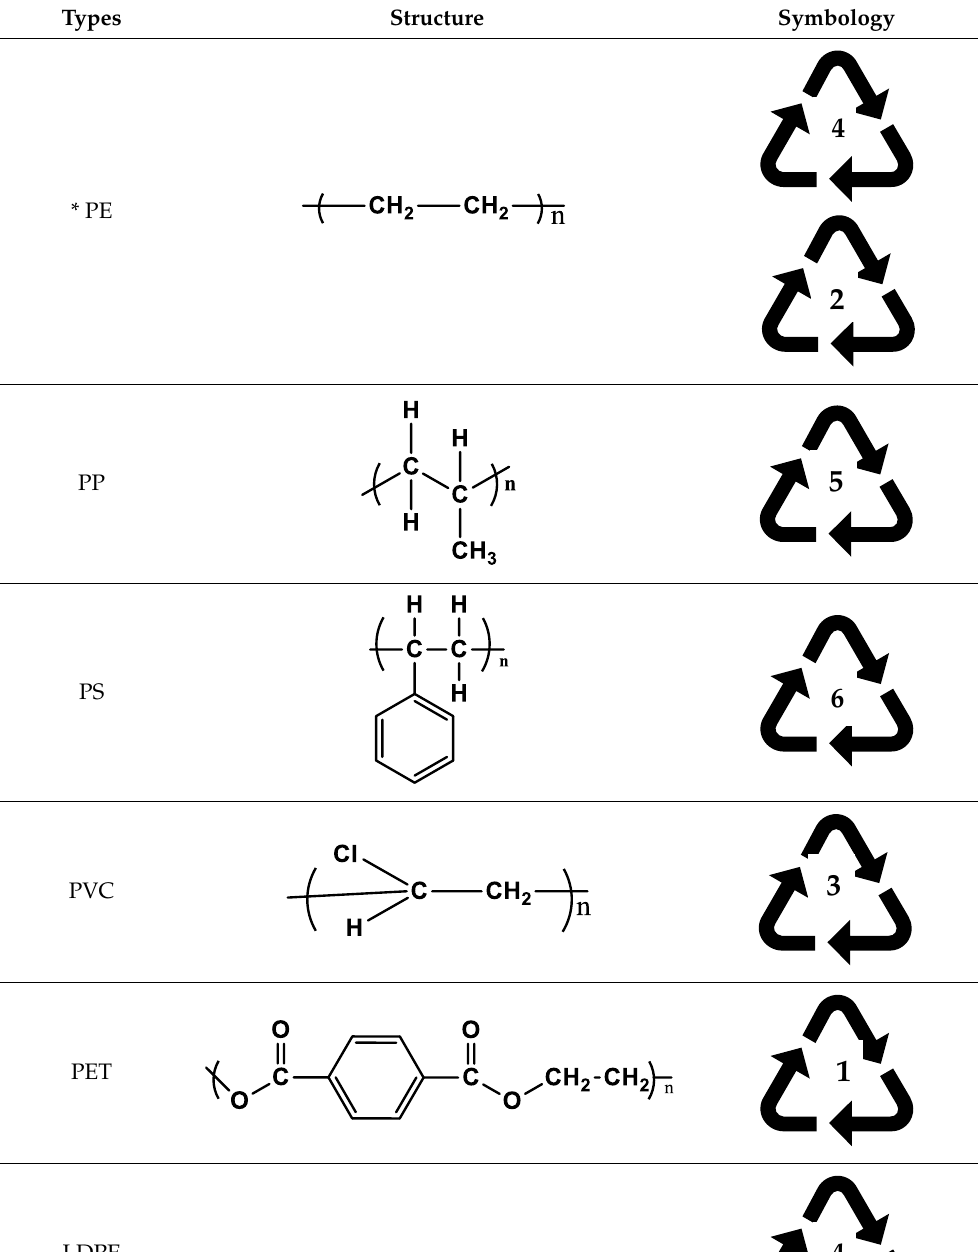
Table 1. Types of plastics, chemical structure, and symbology (Miandad et al. 2017) [47].